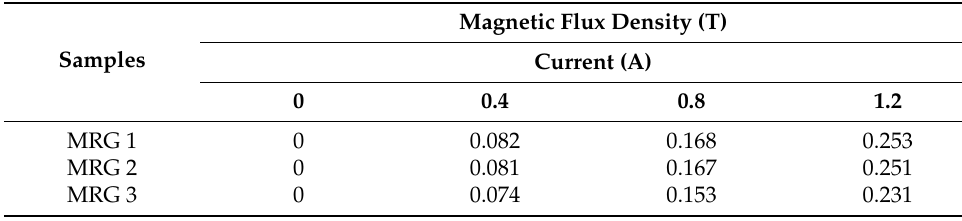
Table 2. Magnetic flux density of